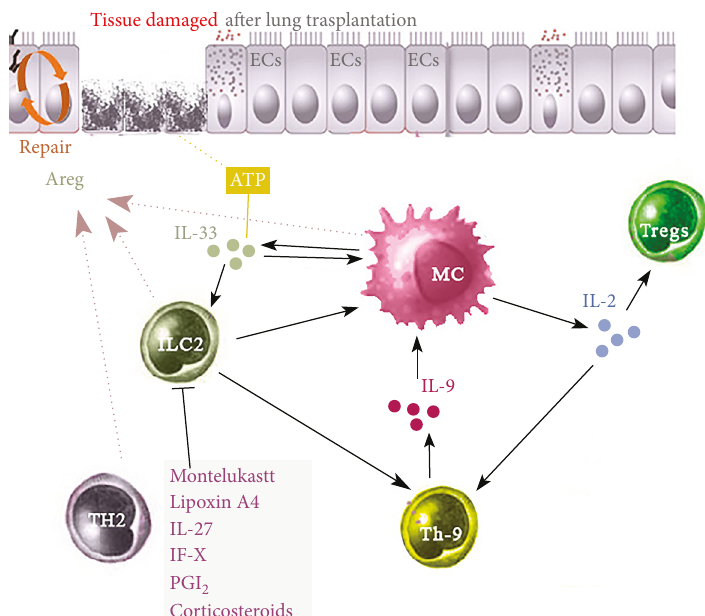
Figure 1: The role of Th9 cells and IL-9 in lung transplantation. IL-9 released by Th9 cells act on MCs to produce IL-2. MC-derived IL-2 leads to the expansion of CD45 + ILC2, which enhances the activation of Th9 cells and the further release of IL-9 in a feed-forward manner. In addition, IL-2 released from MCs induces tolerance in Treg cells and regulates transplantation survival. Activated ILC2s, MCs, and Th2 cells release Areg which is important in promoting EC repair from injury. Damaged epithelial cells, seen during transplant rejection, release IL-33 and ATP, which together can act on ILC2 and MCs to enhance their activity. A number of inhibitors including montelukast, IL-27, corticosteroid, PGI , and lipoxin A4, can suppress the activation and/or proliferation of ILC2s and their release of in fl ammatory 2 mediators. Abbreviations: Areg: amphiregulin; ECs: epithelial cells; IL: interleukin; ILC2: type 2 innate lymphoid cell; MCs: mast cells; PGI2: prostaglandin I2; Th9: T-helper type 9; Treg: T regulatory